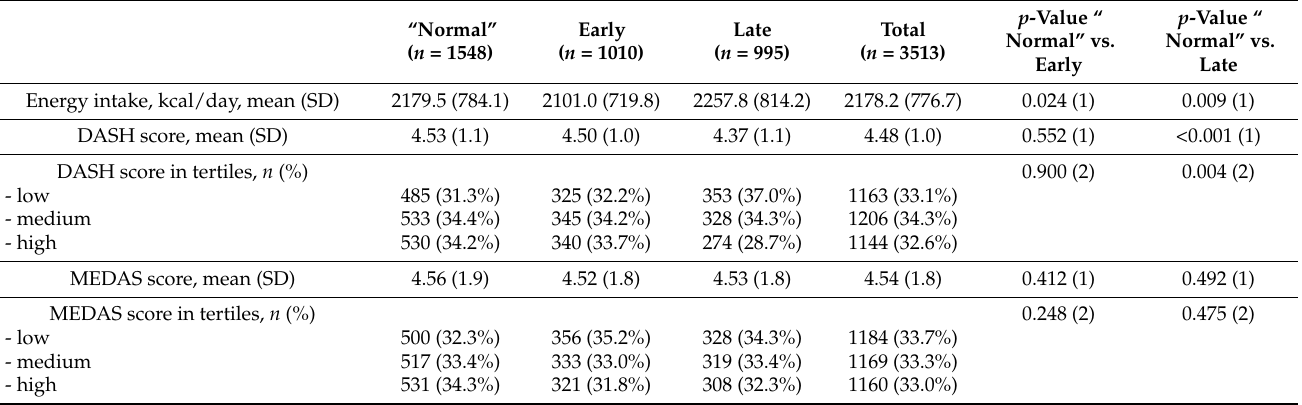
Table 3. Energy and dietary adherence score characteristics stratified after Chorotype. “Normal” ( n = 1548)